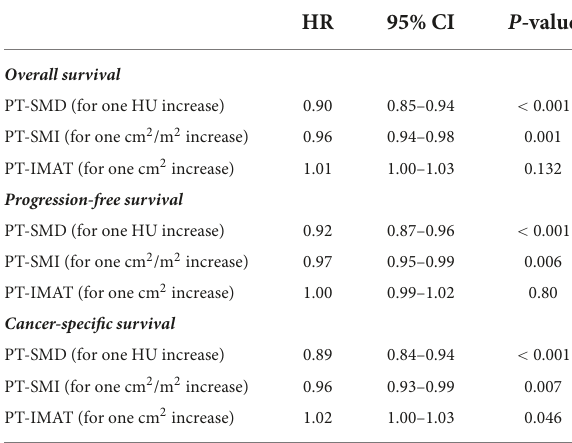
TABLE 5 Multivariate associations of indices of low muscle quality and quantity at the PT level (used as continuous variables) with OS, PFS, and